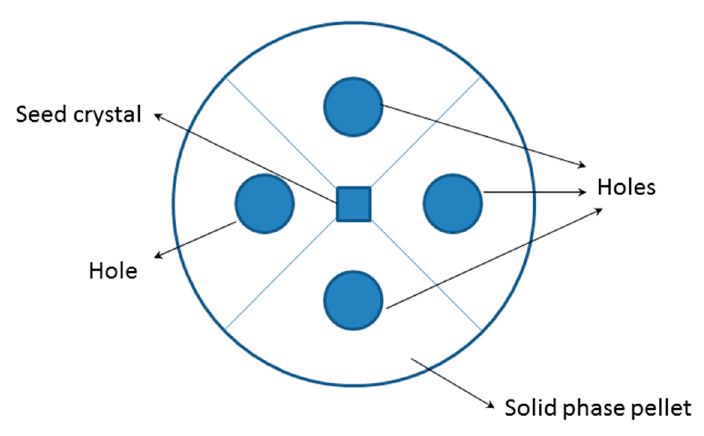
Figure 1. Diagrammatic drawing of the drilled solid phase precursor pellet.